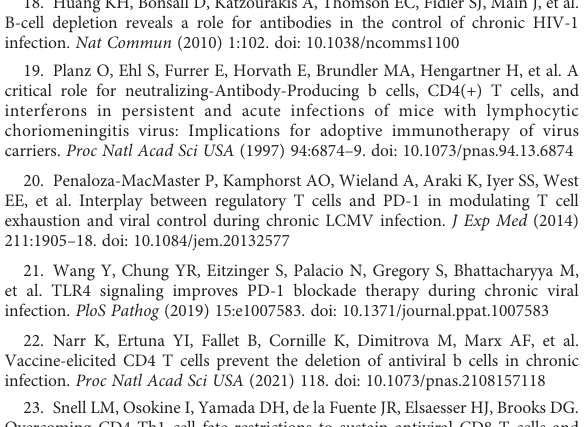
SUPPLEMENTARY FIGURE 1 Splenic germinal center B cell responses following co-transfer of virus- speci fi c CD4 T cells (SMARTA) and B cells (KL25H). (A) Representative FACS plots showing the frequencies of KL25 B cells, isotype-switched B cells, and germinal center B cells in spleen. (B) Percentage of isotype- switched B cells in spleen. (C) Total number of germinal center (GC) B cells in spleen. Experiments were performed 2 times, n=3-5 mice per experiment. Error bars represent SEM. The p-values were calculated using Mann-Whitney test. ns, not signi fi cant.